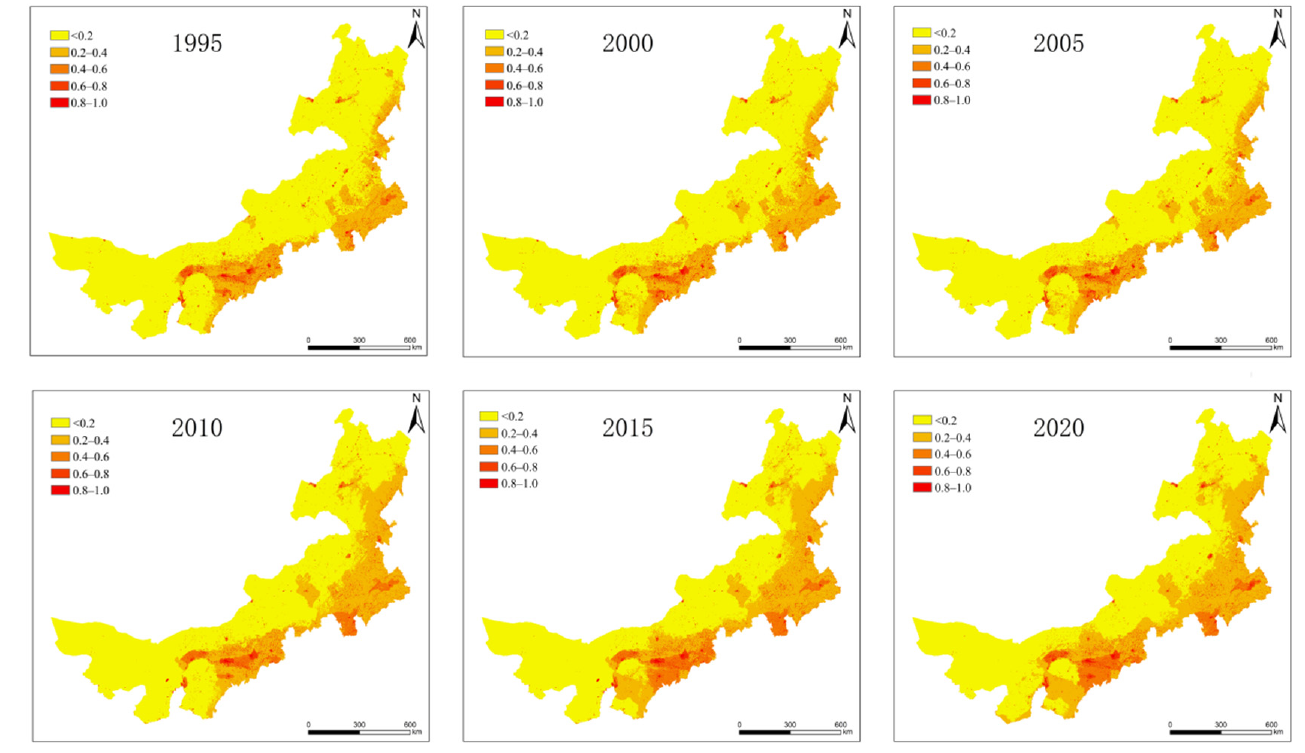
Figure 5. Spatial distribution of urbanization from 1995 to 2020 in Inner Mongolia.